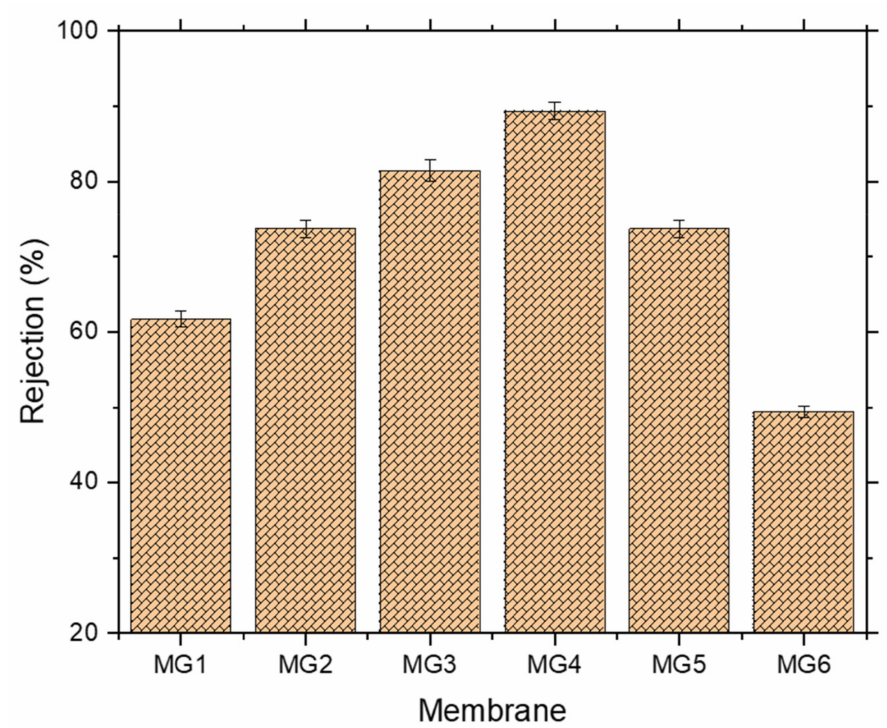
Figure 9. Separation performance of synthesized